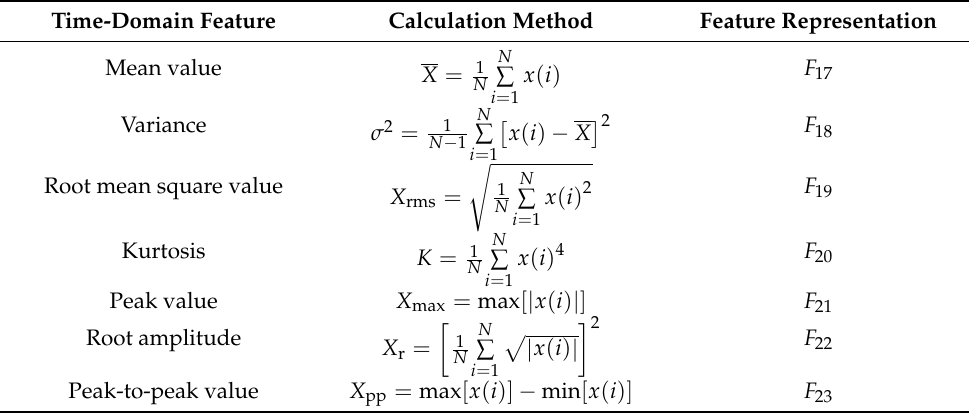
Table 1. Time-domain feature extraction method.